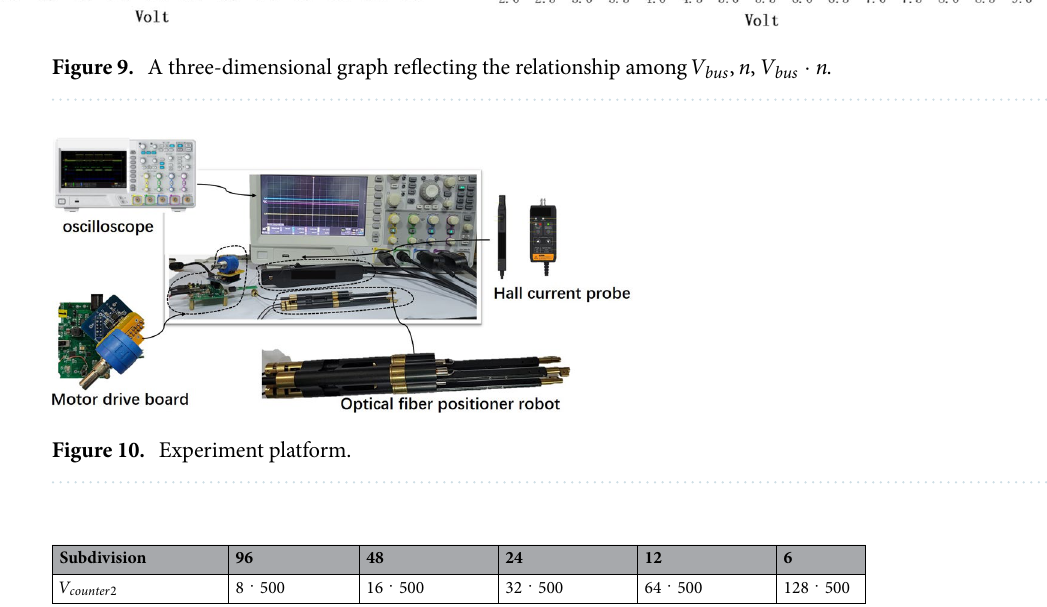
Table 2. Subdivision and V counter 2 (TIM2 cycle count